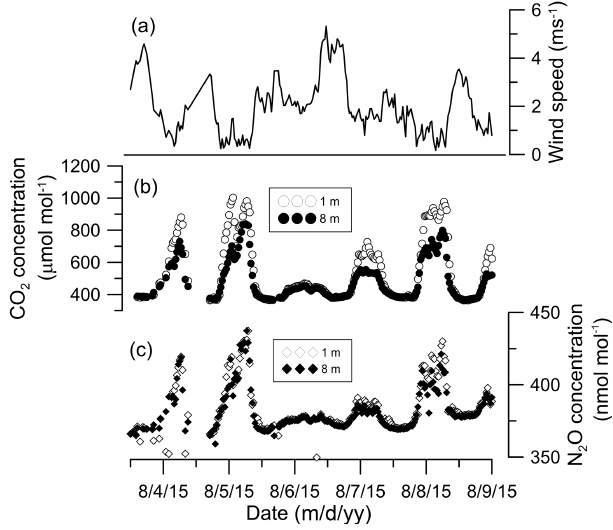
Figure 2. Changes in CO 2 and N 2 O concentrations at the bottom and top of the measured control volume relative to wind speed at 8m. The wind speed at 8m ( a , right ordinate), the CO 2 concentra- tions at 1 and 8m ( b , left ordinate), and the N 2 O concentrations at 1 and 8m ( c , right ordinate) are indicated for a 5-day period. Dates on the abscissa are indicated at the beginning of the indicated day (mid- night). Note the increase in wind speed during the 5 August 2015 night corresponds to a decrease in both the 1 and 8m concentrations of both CO 2 and N 2 O. Date/time is local time.